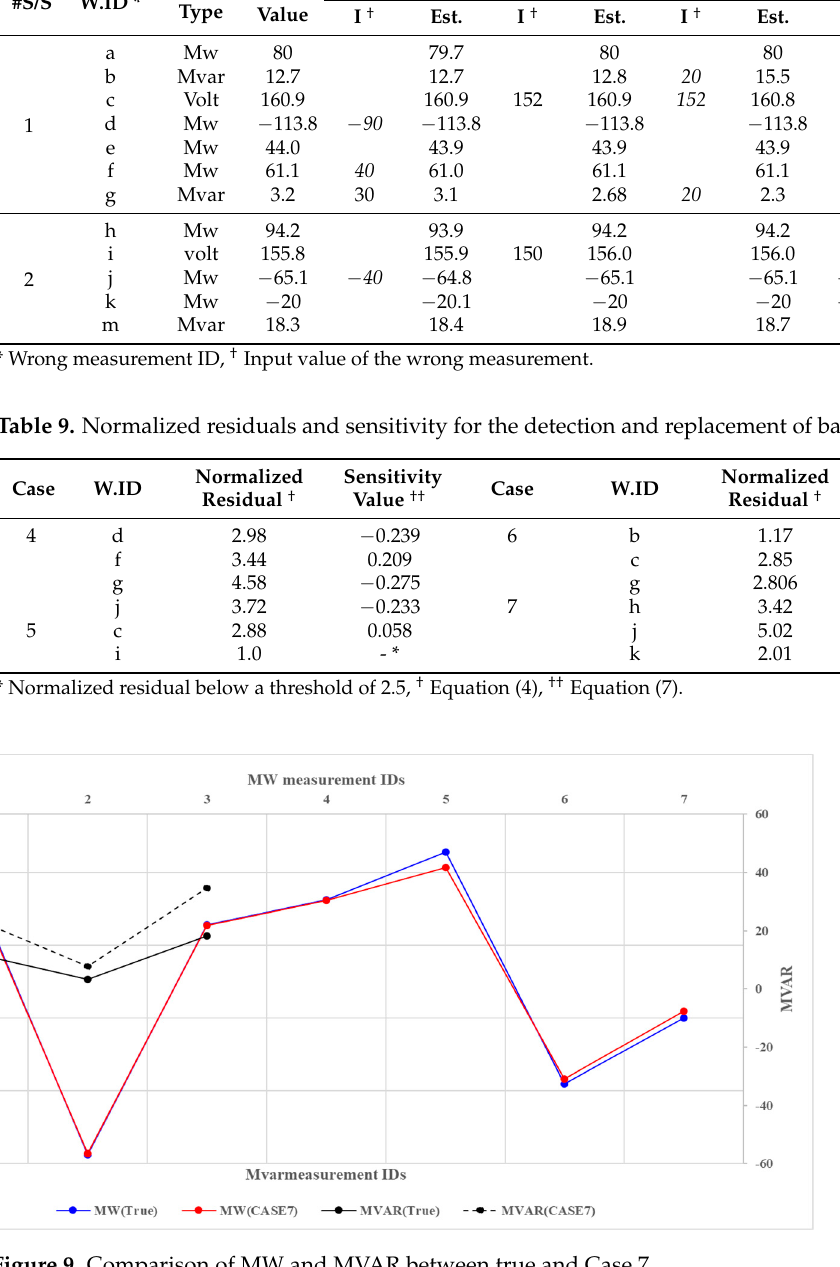
Table 8. Results of the bad data processing for Scenario B.